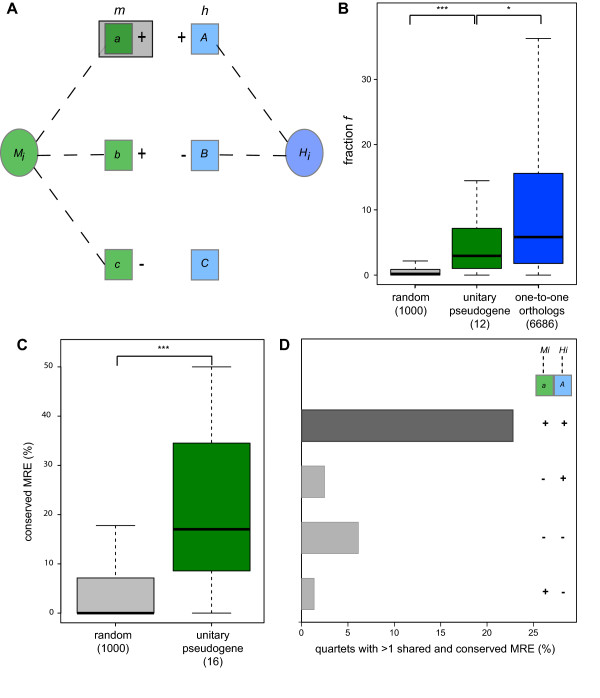
Conserved genetic interactions of transcribed unitary pseudogenes. (a) We estimated the correlation in expression between orthologous mouse (green) or human (blue) loci (Mi and Hi, respectively, ovals) and other protein-coding genes (rectangles) annotated in mouse or human genomes. We retained only genes exhibiting significantly (empirical P-value < 0.05) positive (+) and negative (-) correlation with Mi or Hi tissue expression (dashed line). We identified all mouse genes (for example, 'a' boxed) whose expression profiles are significantly correlated with that of Mi, and whose human one-to-one ortholog (for example, 'A') is also significantly correlated in the same direction with Hi. (b) f is the fraction of mouse genes, m, that are significantly correlated in expression with a unitary pseudogene, Mi, whose human orthologs are also significantly correlated in expression (and in the same direction, either positively or negatively) with Hi, the human ortholog of Mi. f for human protein-coding gene and mouse unitary pseudogene pairs (green) is significantly higher (***P < 0.001) than for random non-orthologous mouse and human gene pairs (grey) and significantly lower (*P < 0.05) for mouse and human one-to-one orthologs. No constitutively expressed exons (required to measure gene expression) were identified for EXD3, THAP9, RNF175, DBF4B and ZBED. Hence these genes were not considered in this analysis. (c) Unitary pseudogenes (green) share significantly (***P < 0.001) more MREs with their human protein-coding ortholog 3' UTR than random pairs of mouse and human protein-coding genes (grey). MRE predictions were not available for ZBED5 and this locus was not considered in this analysis. (d) Twenty-two percent of conserved significantly positively (++) correlated quartets (Mi-A-a-Hi, dark grey) share at least one MRE for the same miRNA family across the four loci. This is a significantly higher fraction than found for quartets that are significantly negatively correlated (--) or significantly correlated (+- and -+) in different directions (light grey).